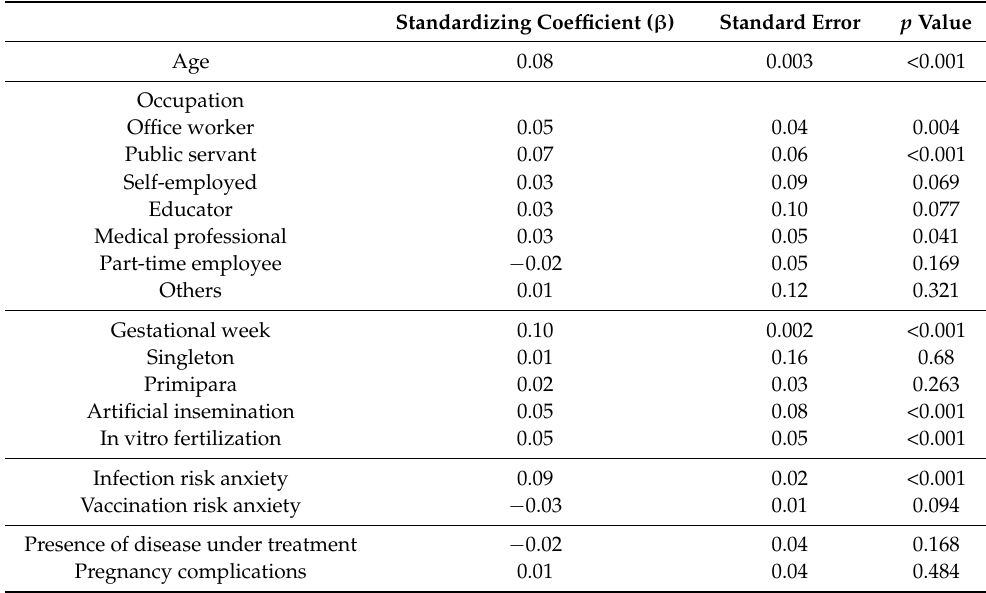
Table 3. Characteristics of pregnant women using professional medical